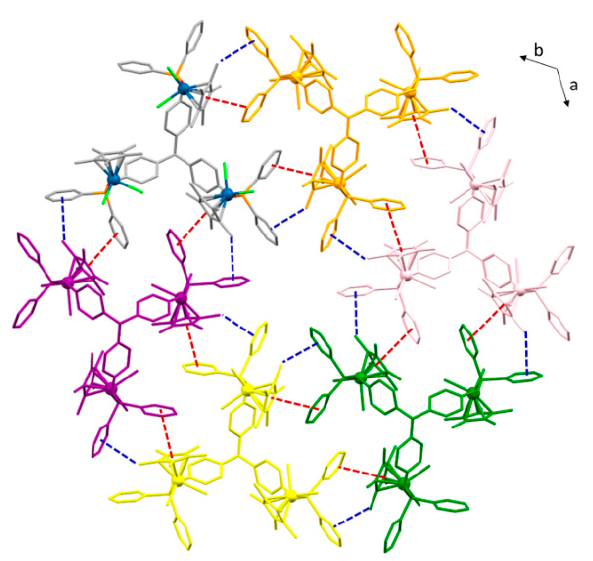
Figure 5. Projection of the crystal structure of 6a along [0 0 1] highlighting intermolecular π — π (red dotted lines) and C—H/ π (blue dotted lines) interactions between triiridium compounds. Each molecule of 6a has been highlighted in different colors for clarity, while metal centers are represented as